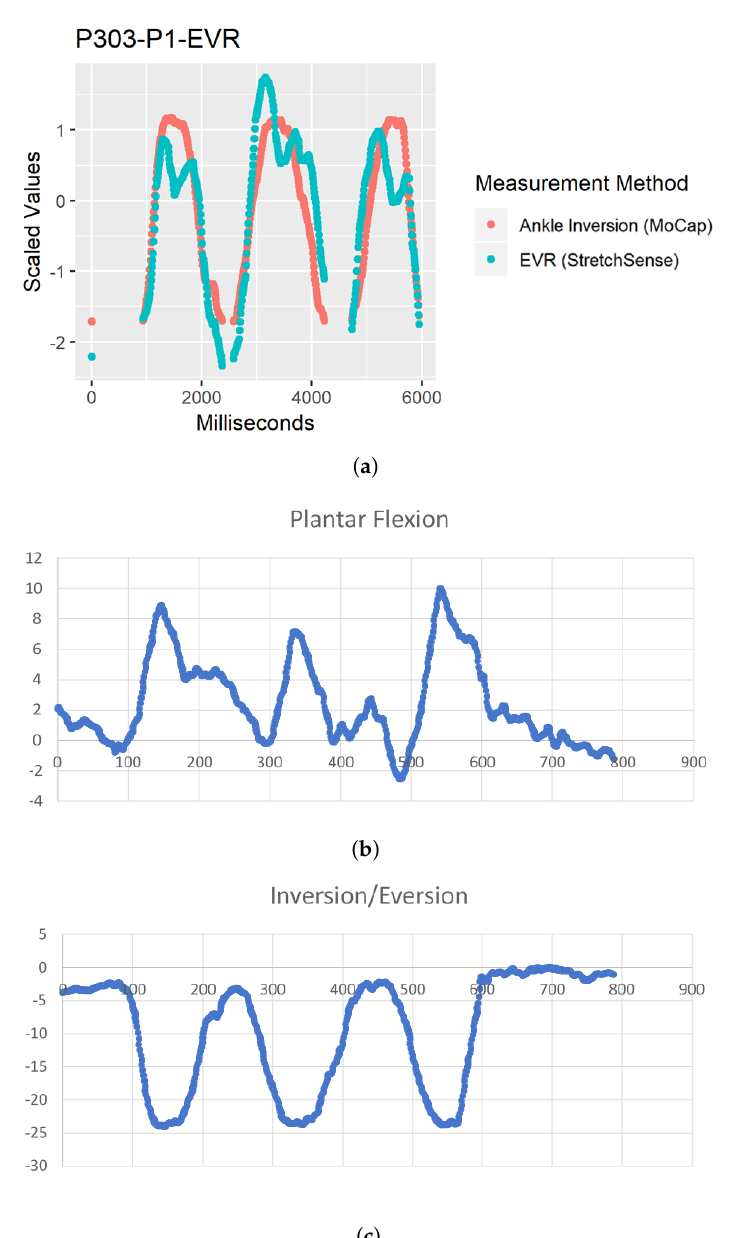
Figure 13. ( a ) Comparison of motion capture and StretchSense when EVR movement not performed in isolation. Both datasets scaled and motion capture data inverted to depict relationship between sensing methods. ( b ) Raw motion capture data for PF movement. ( c ) Raw motion capture data for EVR movement (negative